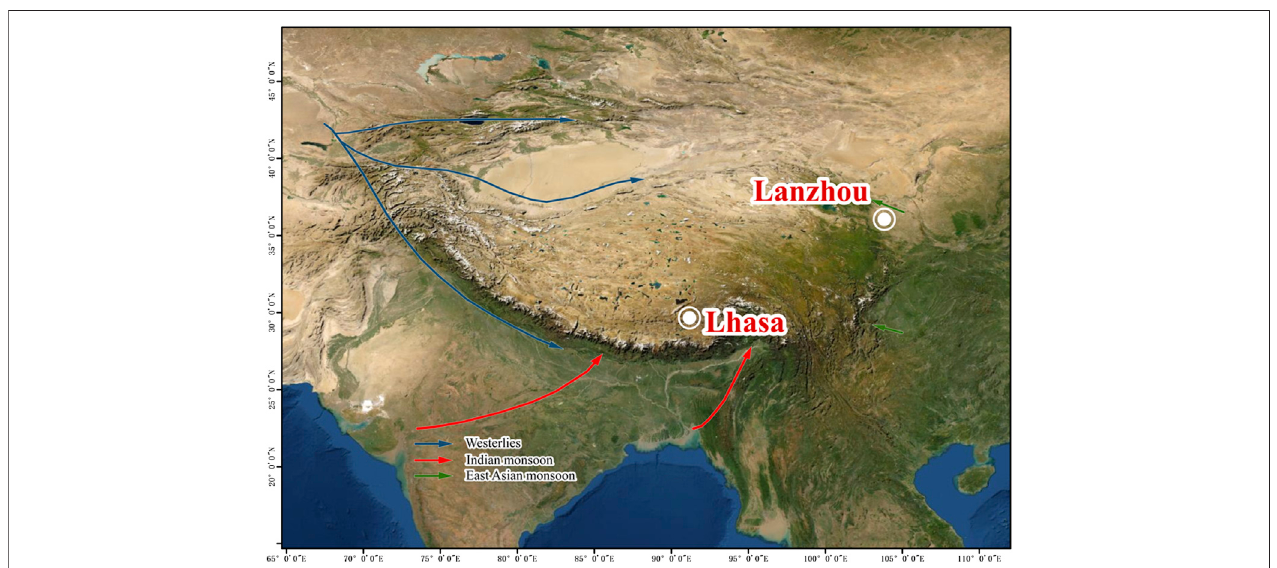
FIGURE 1 | Location of the cities of Lanzhou and Lhasa.